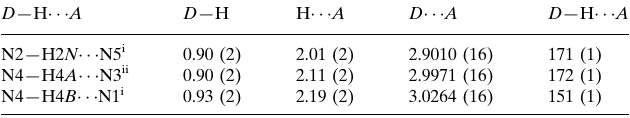
Hydrogen-bond geometry (A˚ , (cid:1)